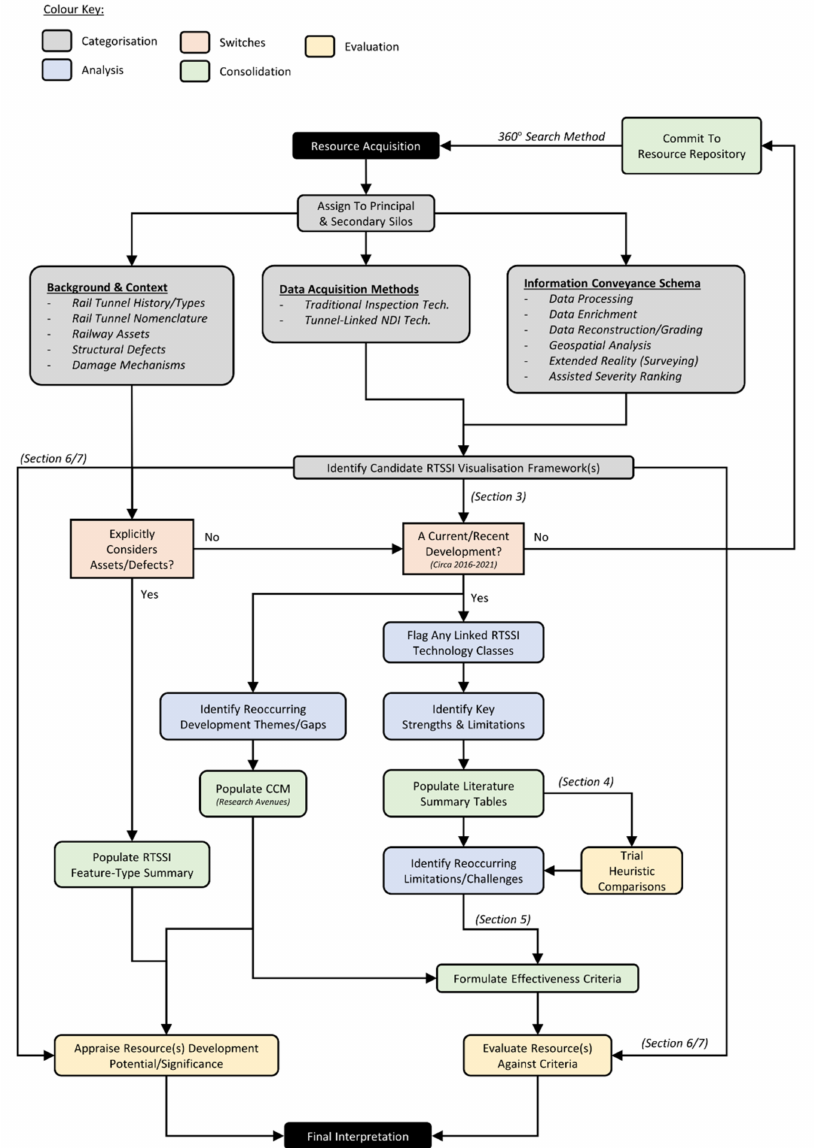
Figure 1. Flowchart of reviewing procedure prescribes handling, analysis and management of resources, alongside providing a rigorous procedure for appraising the effectiveness and scope of frameworks